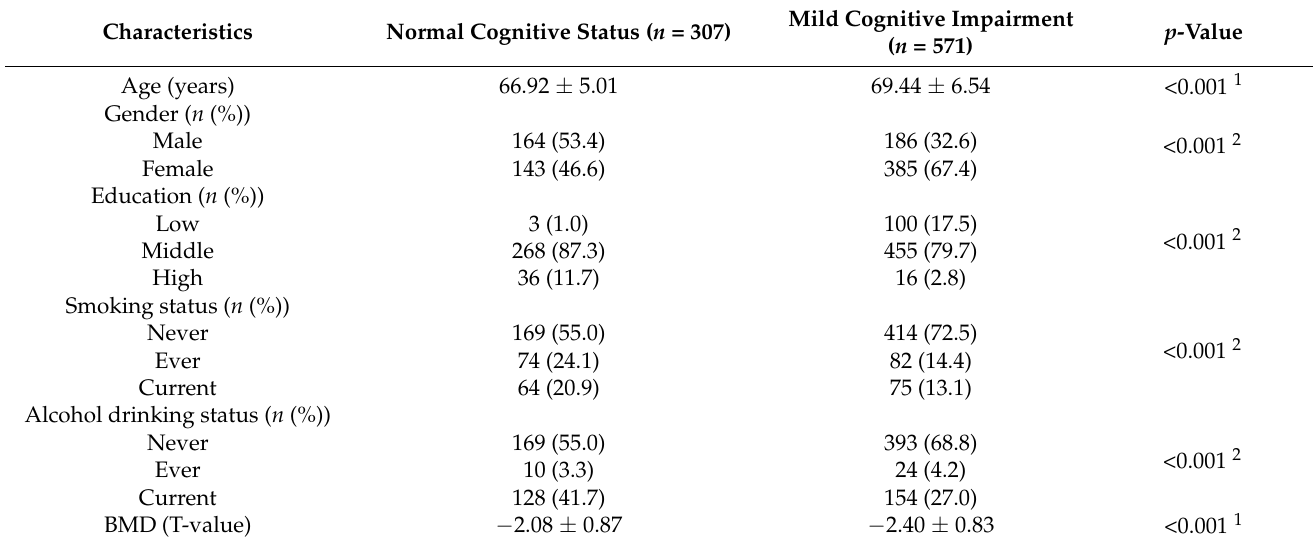
Table 1. The characteristics of the sample by cognitive functions.